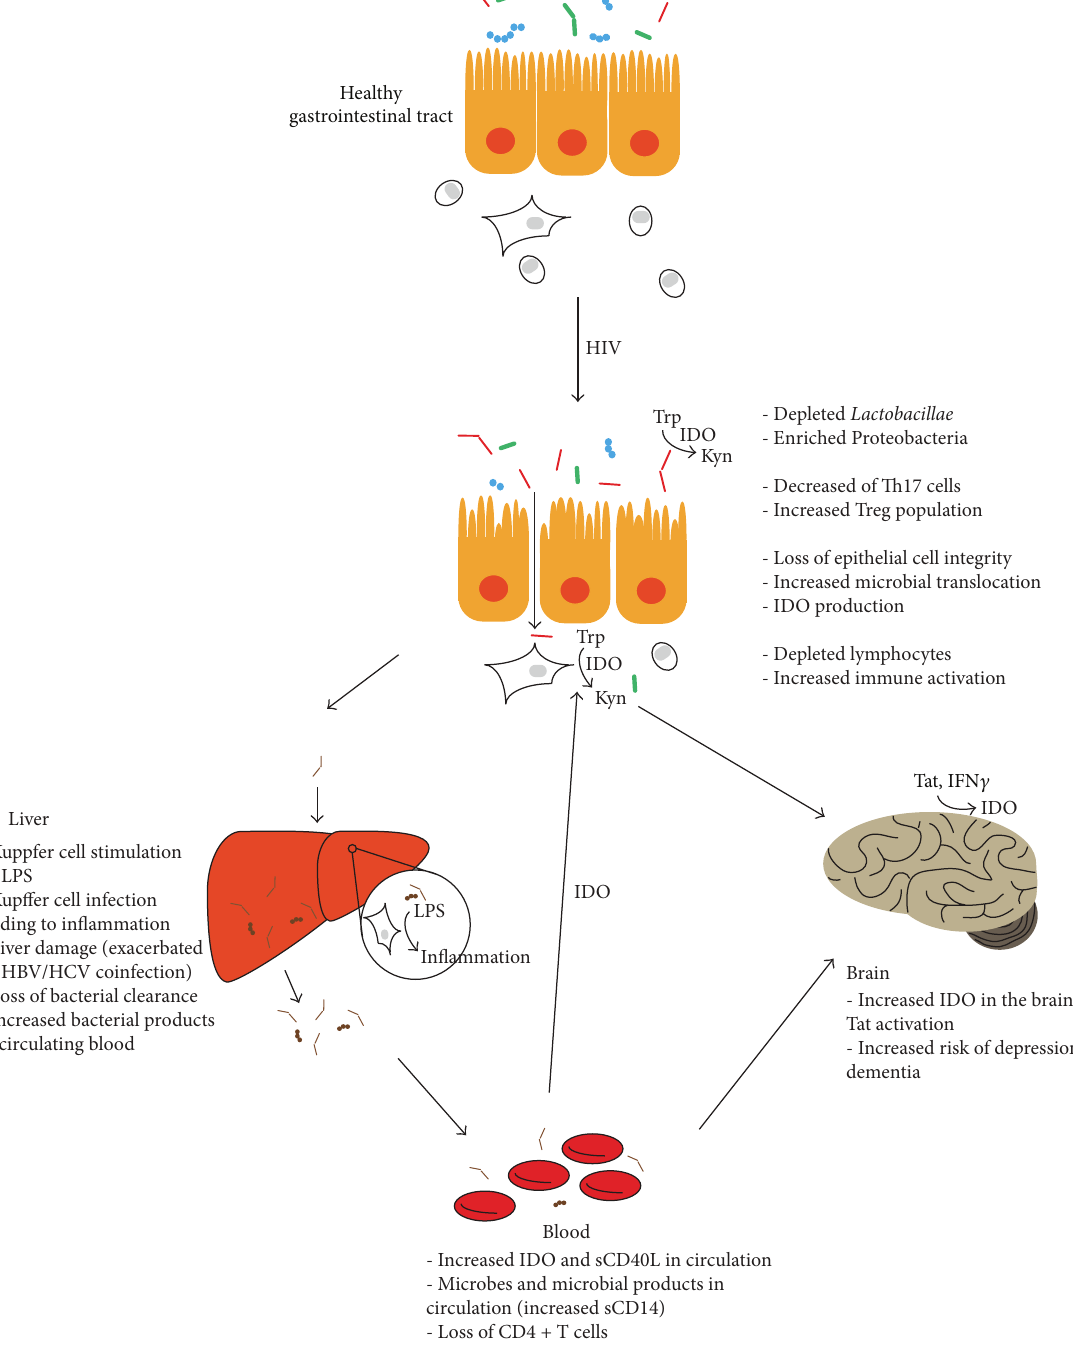
Figure 1: The vicious cycle of HIV infection. HIV infection has immediate effects in the gut where lymphocytes are depleted and damage to the endothelium allows for microbial translocation. Microbiota, when not cleated by the liver, go on to have systemic effects most notably through IDO production which is capable of creating a vicious cycle of